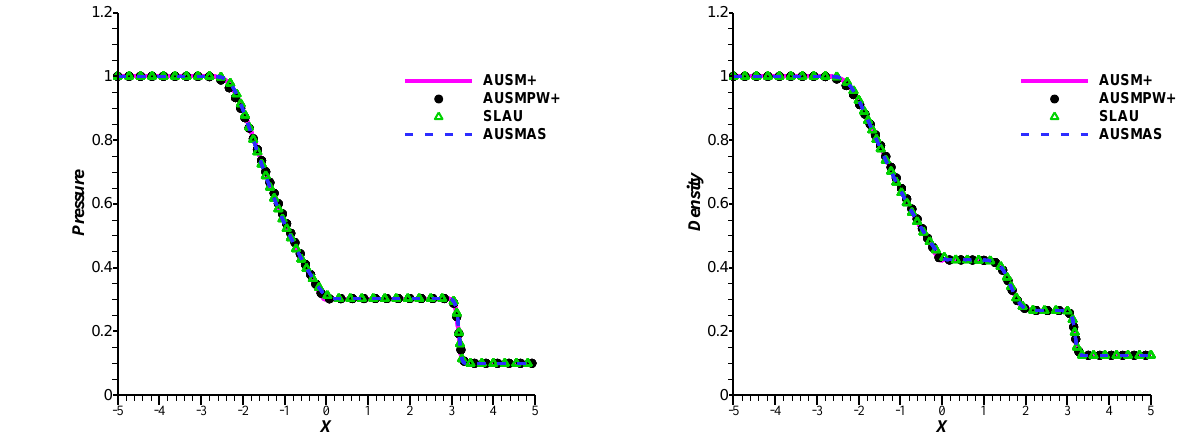
Figure 8. Pressure and density distributions of the Sod shock tube test ( t = 1.8 s).